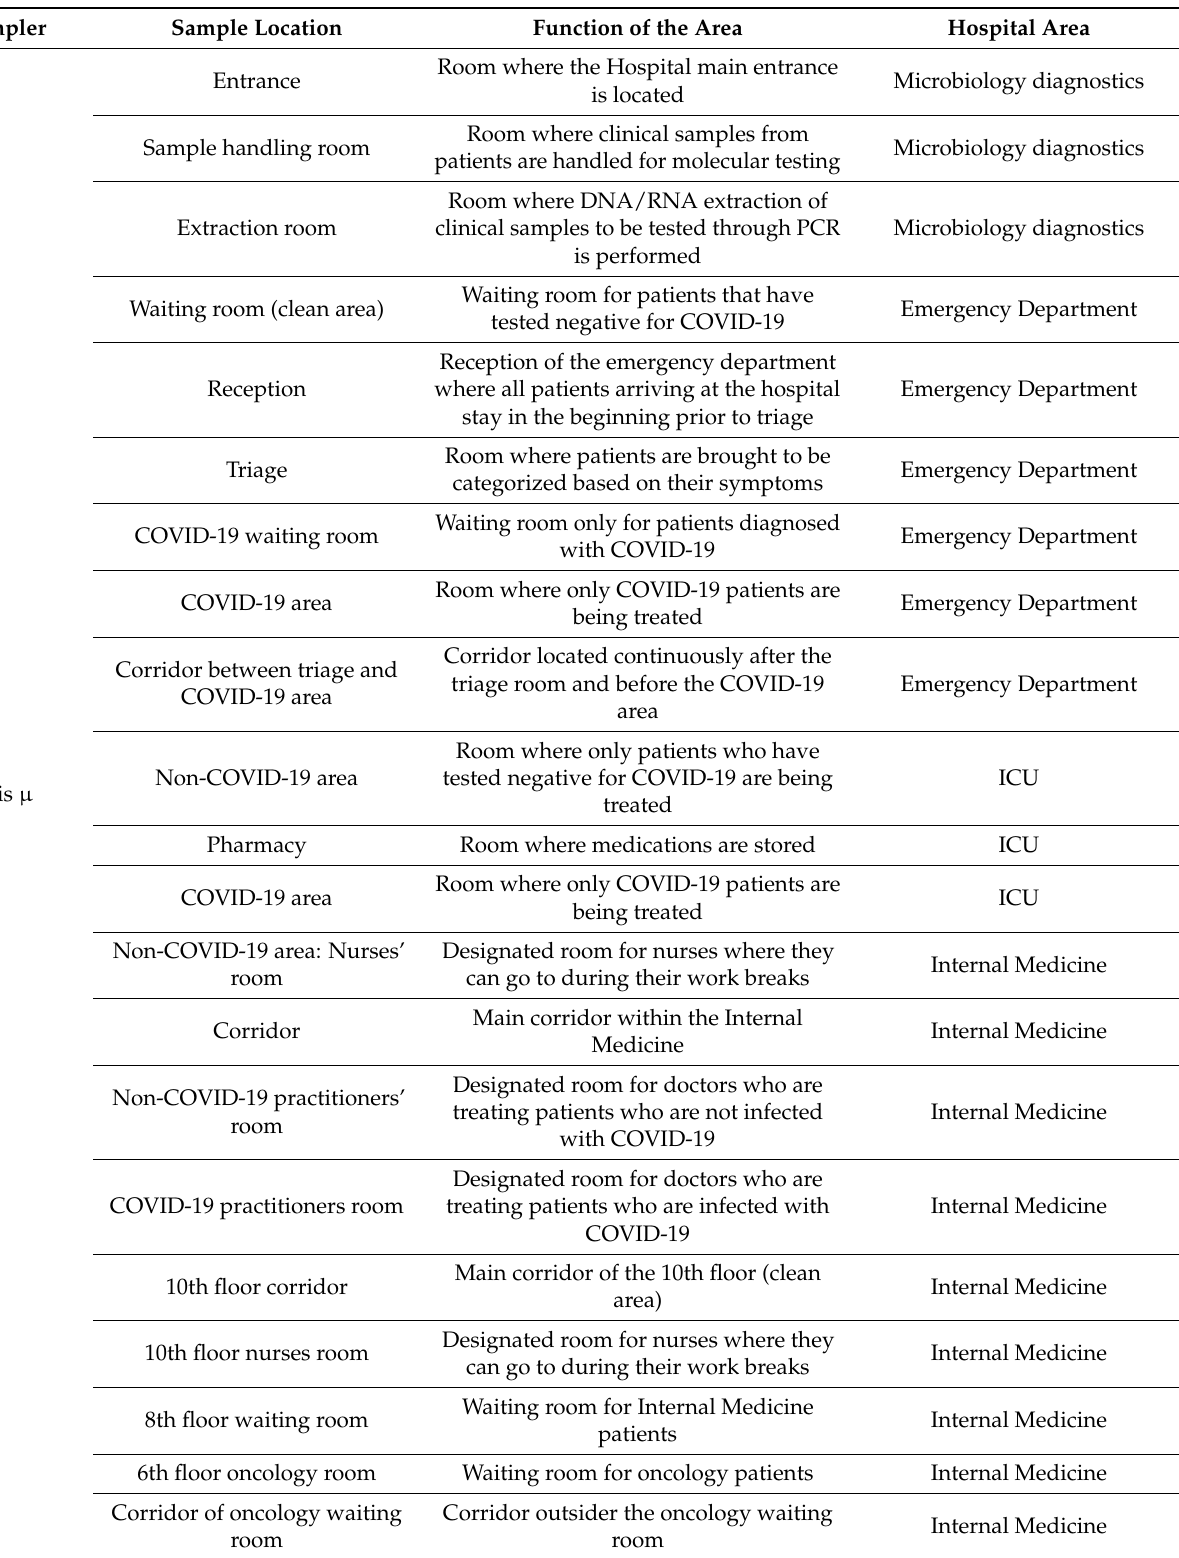
Table 1. Details from air samples